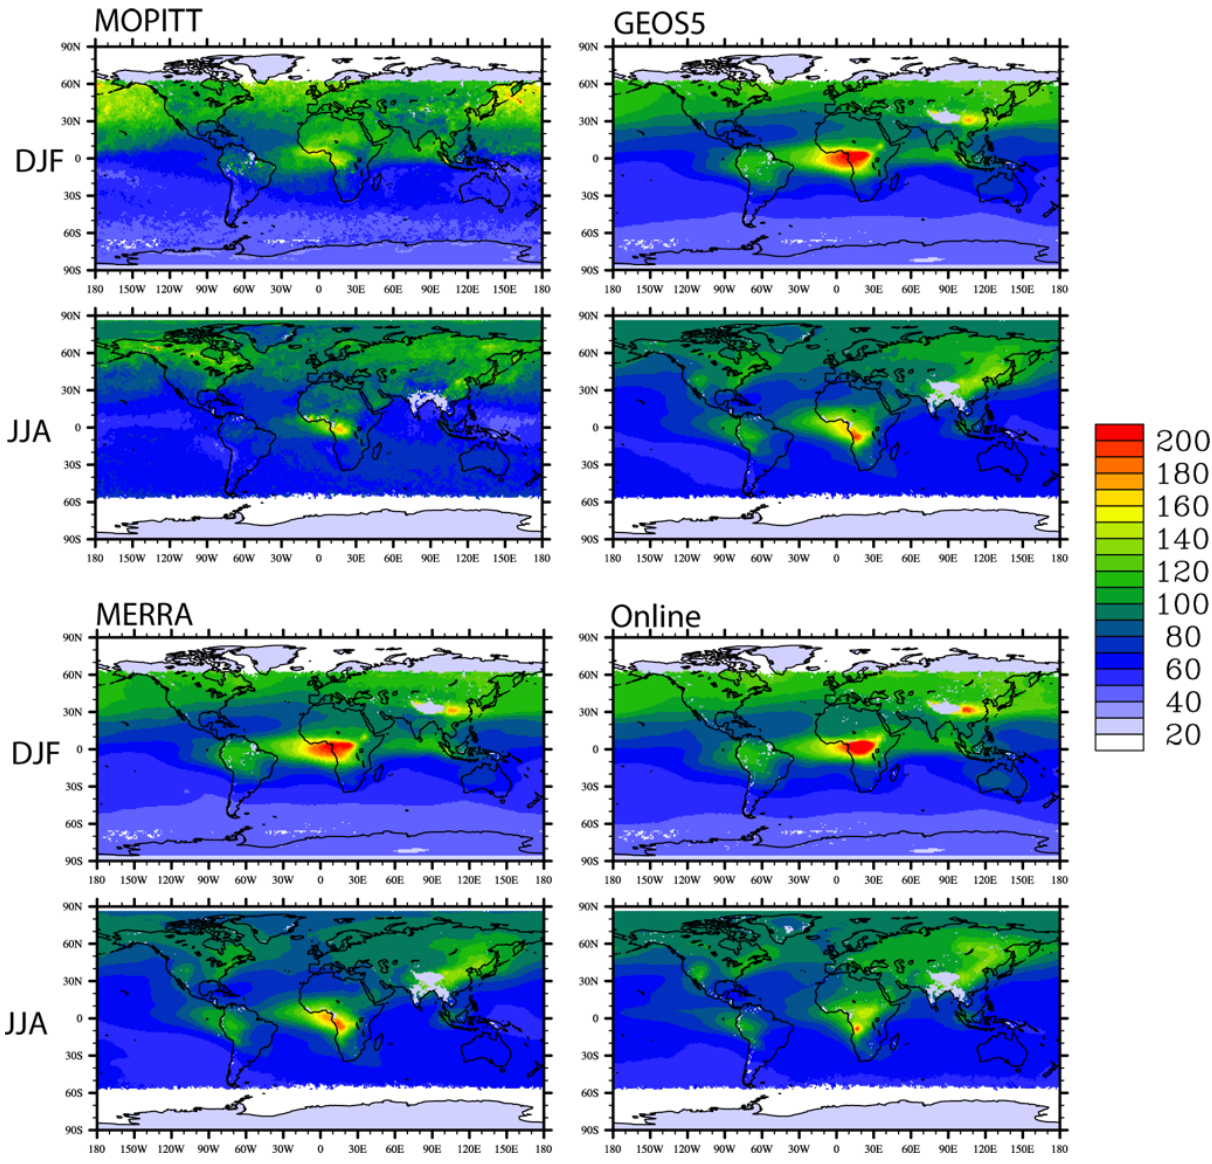
Fig. 12. Comparison of MOPITT (2004–2009) climatology of day-time CO (ppbv) retrievals at 500hPa with model results (convolved with a priori and averaging kernels) for winter (DJF) and summer (JJA). Model results are averaged over the same period.